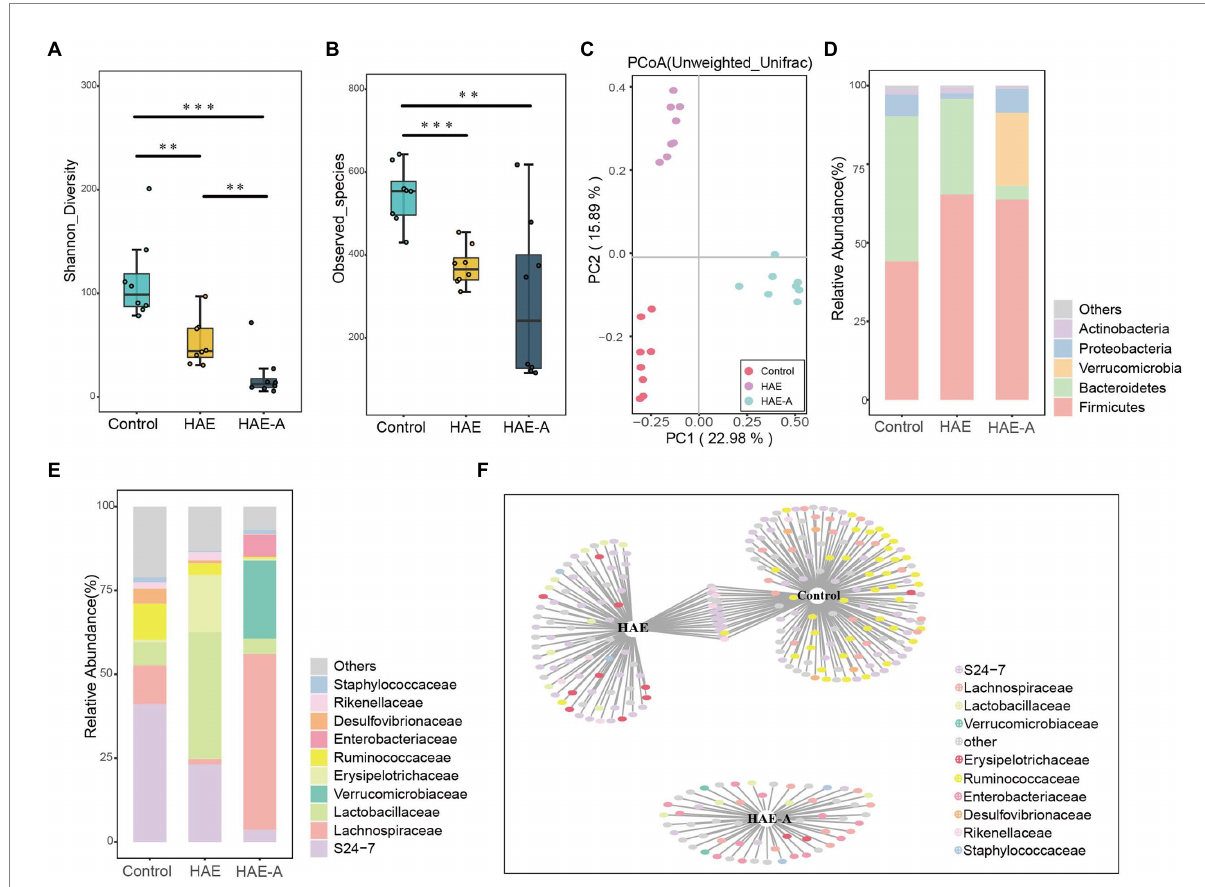
FIGURE 6 Effects of hypoxia on the structure of colon microbiota in normal mice and antibiotic drinking mice. (A) Intestinal microbial community diversity in each group (Shannon). Meaning: Wilcoxon. (B) Gut microbiome richness (observed species) in colonic luminal samples of each group. Significance: Wilcoxon. (C) Principal Coordinate Analysis (PCoA) of Unweighted UniFrac Distance between groups. (D) Relative abundance at phylum level in each group (%). (E) Relative abundance at each family level (%). (F) Bipartite networks of indicator species analysis. It displays different treatment-specific ASVs in the colonic bacterial communities using indicator species analysis. Circles represent individual bacteria and ASVs that are positively and significantly associated ( p < 0.05) with one or more different grouping factors (association(s) given by connecting lines). ASVs are colored according to their Family